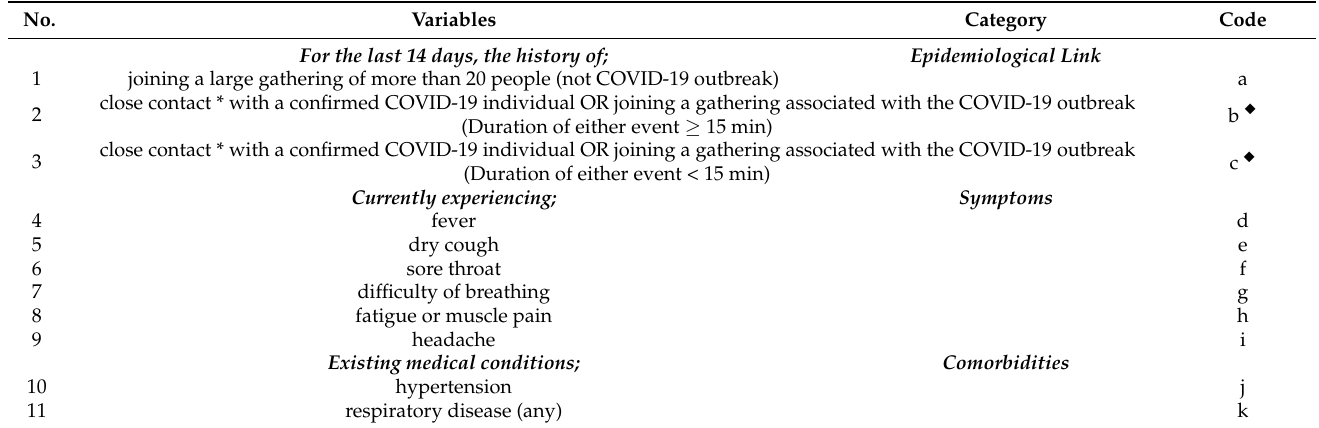
Table 1. Important predictors of the COVID-19.